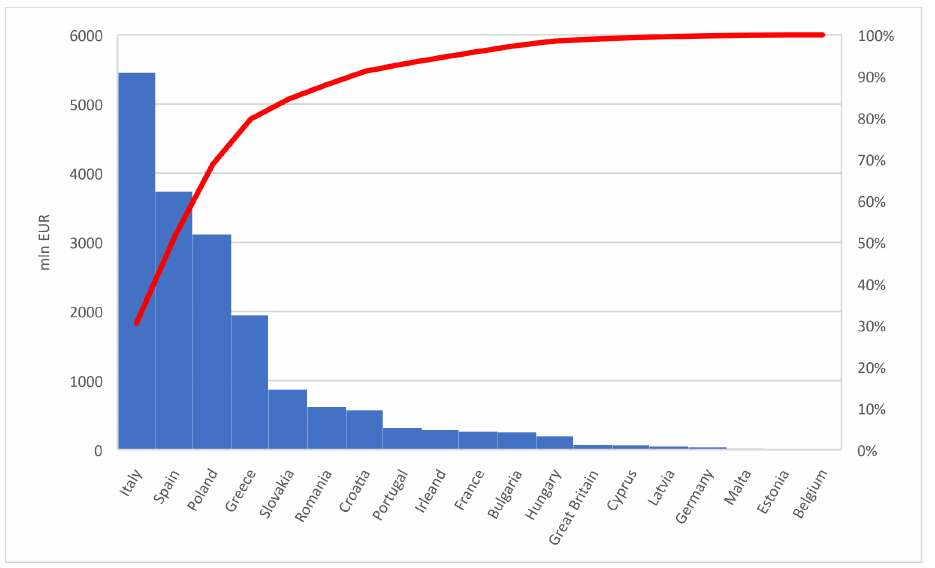
Figure 2. Total and cumulative value of support provided in EUR to combat the effects of pandemic COVID-19.